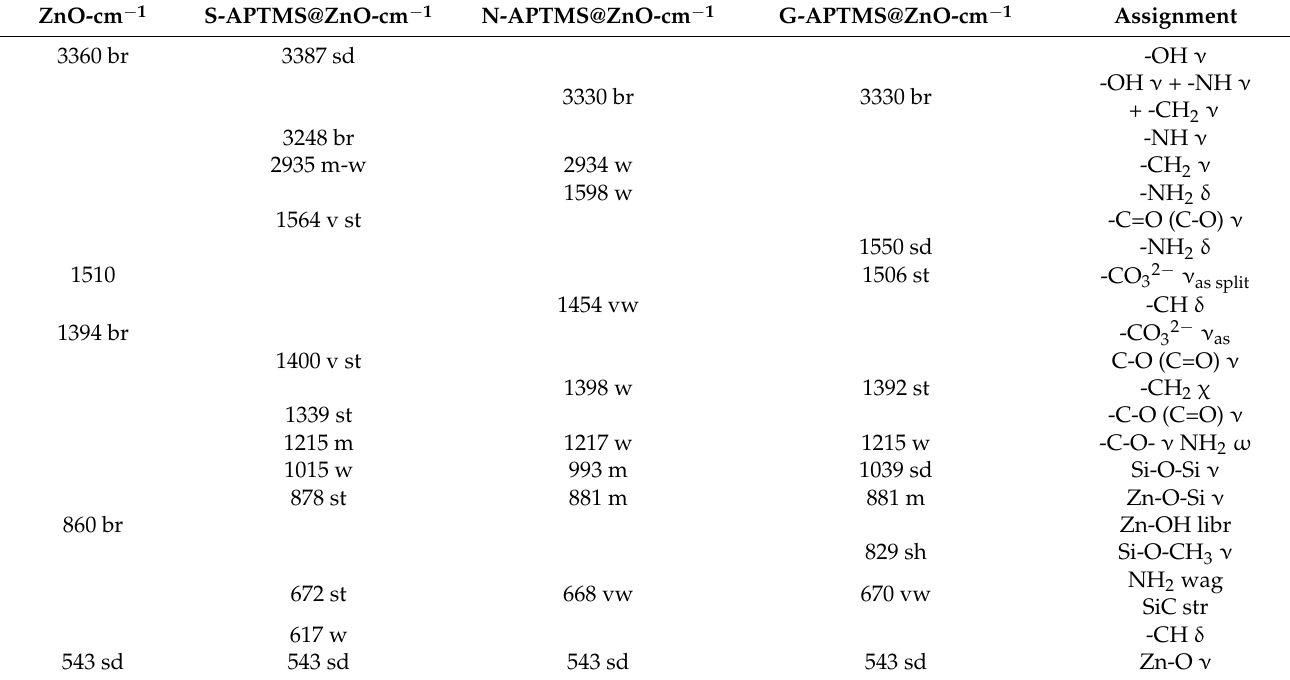
Table 2. Assignment of the IR features. Sh = sharp, st = strong, m = medium, v st = very strong, w = weak, vw = very weak, sd = shoulder, br = broad, ν = stretching, δ = bending, ω = wagging, χ =